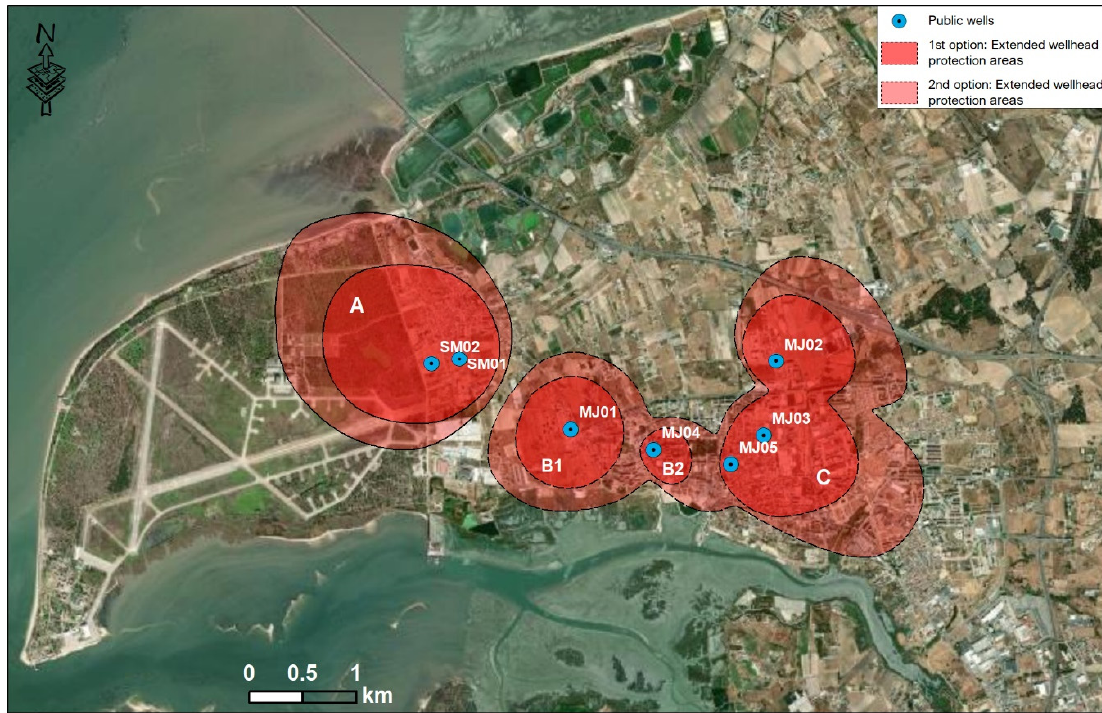
Figure 13. Extended wellhead protection zones calculated by numerical modelling.